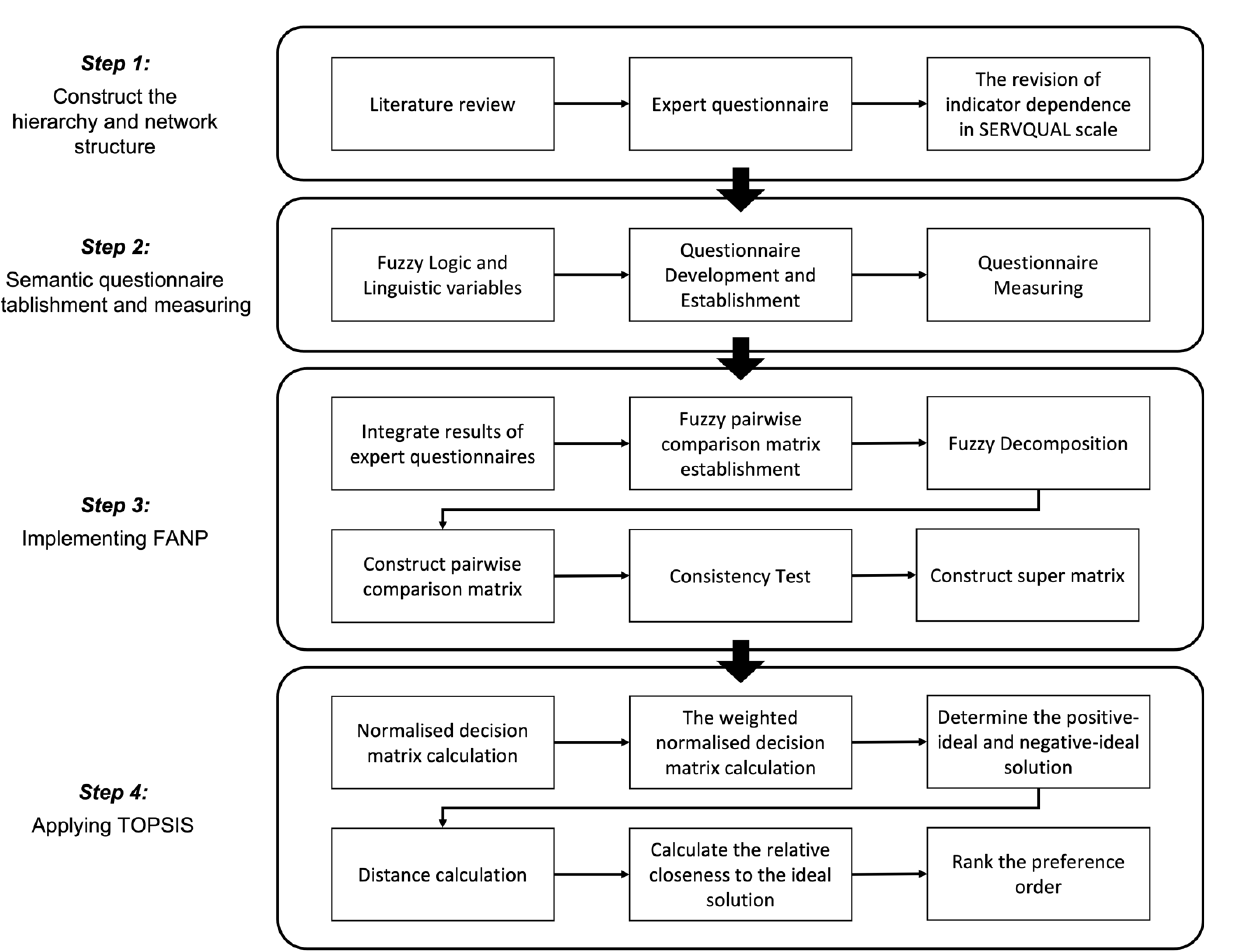
Figure 1. The process of this